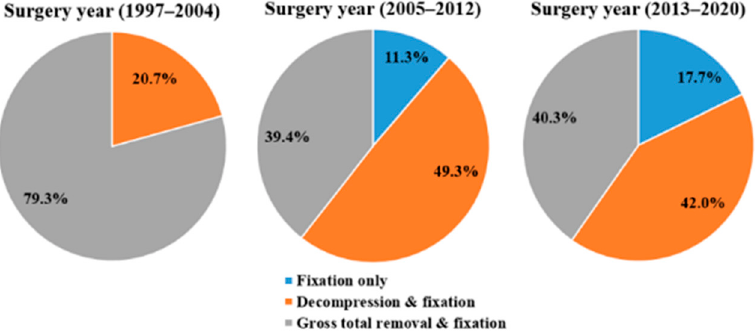
Figure 1. Trends in surgical methods for metastatic spinal tumors according to the year of surgery.